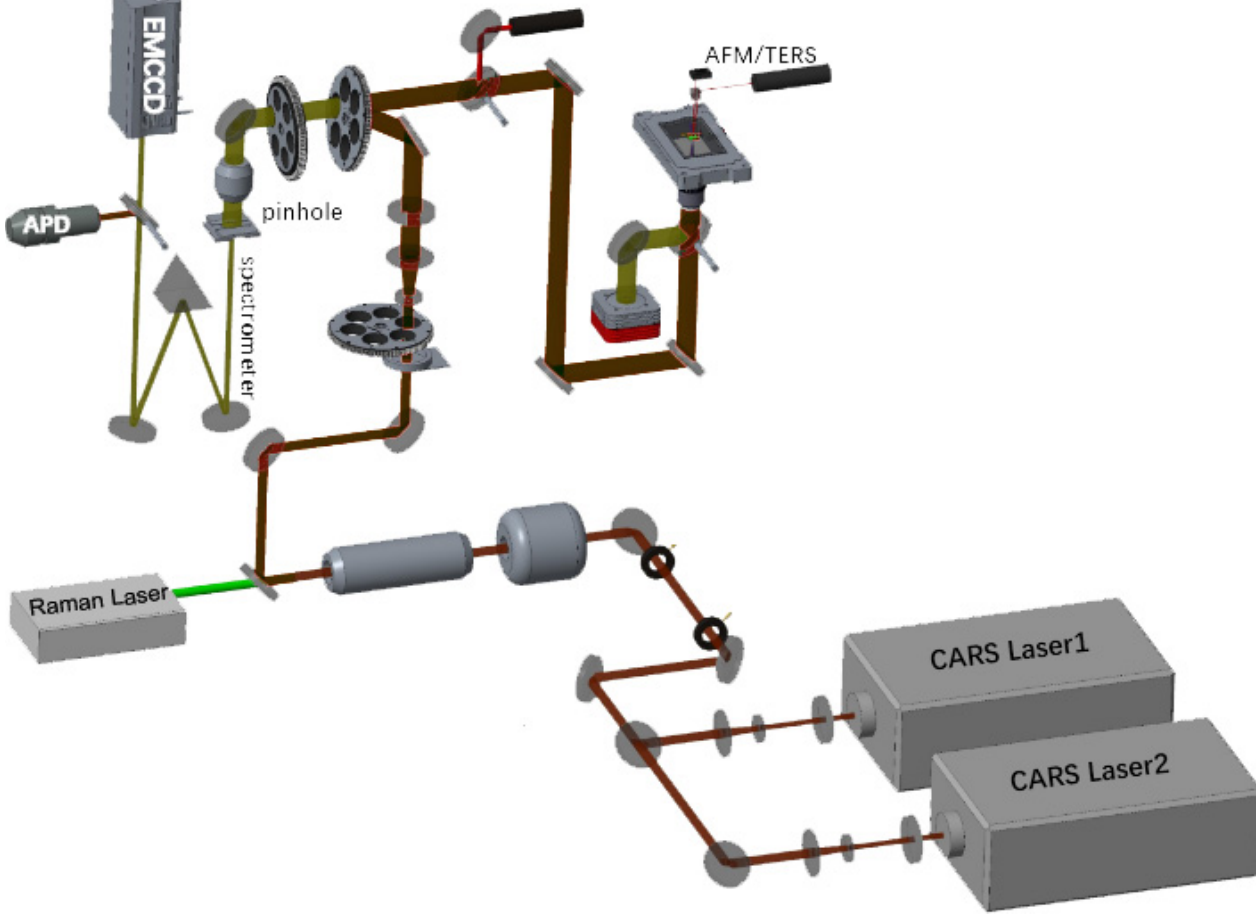
Fig. 2. Schematic of TECARS